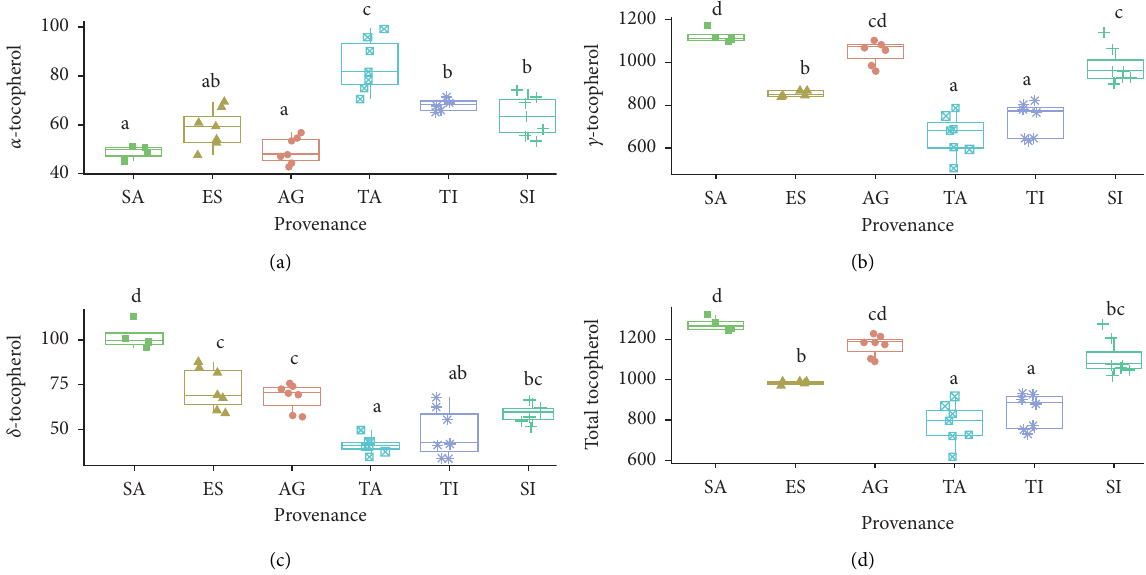
Figure 2: Boxplot of: (a) α -tocopherol, (b) c -tocopherol, (c) δ -tocopherol, and (d) total to copherolin argan oil samples collected in different provinces (Safi: SA, Essaouira: ES, Agadir: AG, Taroudant: TA, Tiznit: TI, and Sidi Ifni: SI). Significant differences ( p < 0 . 05) were expressed by different